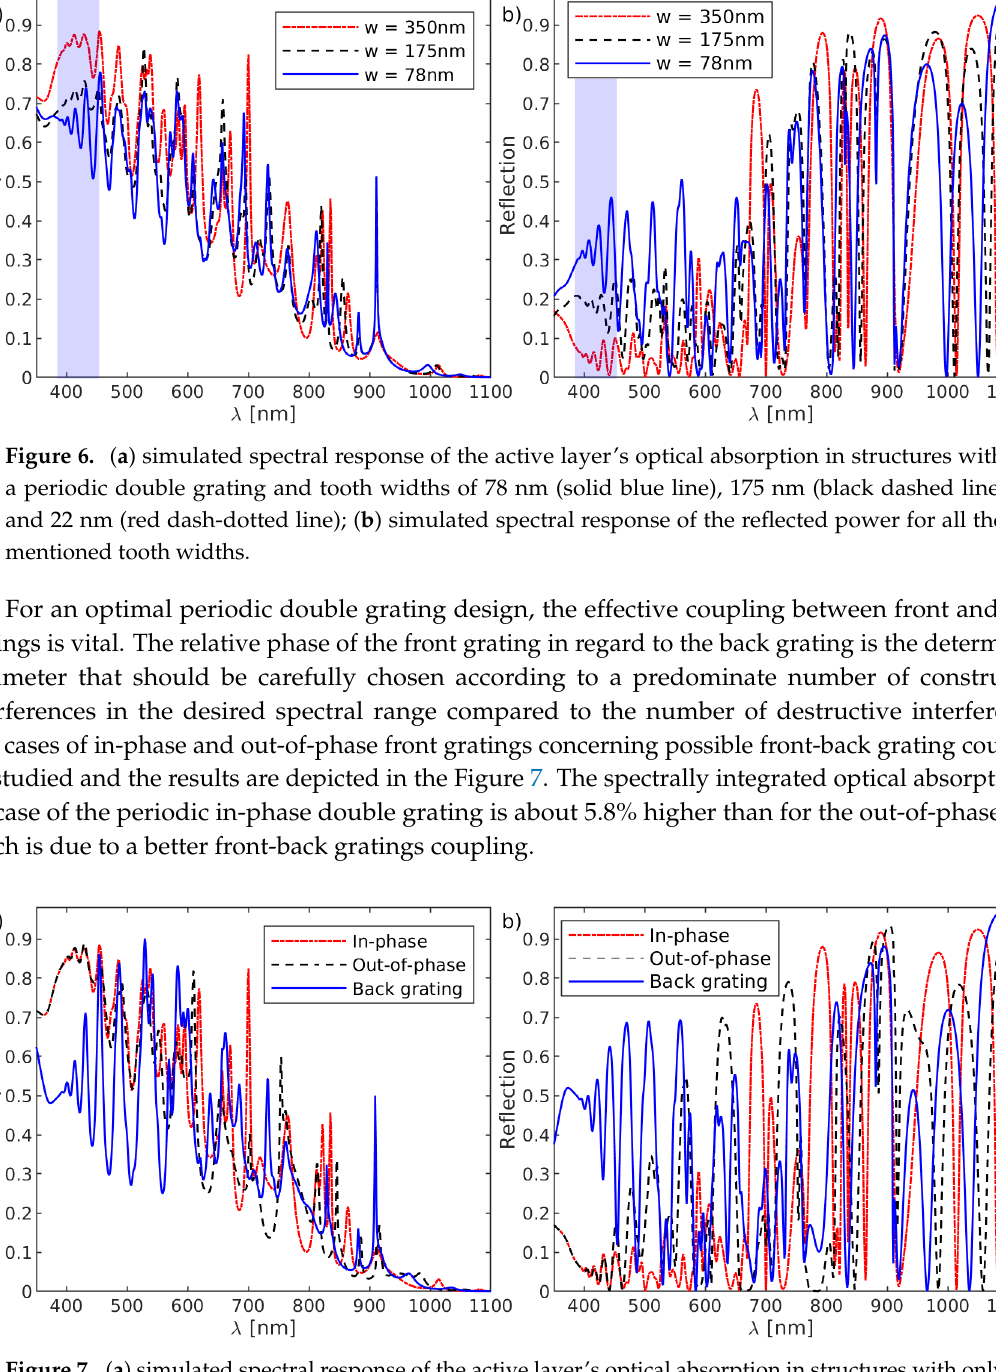
Figure 7. ( a ) simulated spectral response of the active layer’s optical absorption in structures with only a periodic back grating (solid blue line), an out-of-phase double grating (black dashed line) and an in-phase double grating (red dash-dotted line); ( b ) simulated spectral response of the reflected power for all mentioned